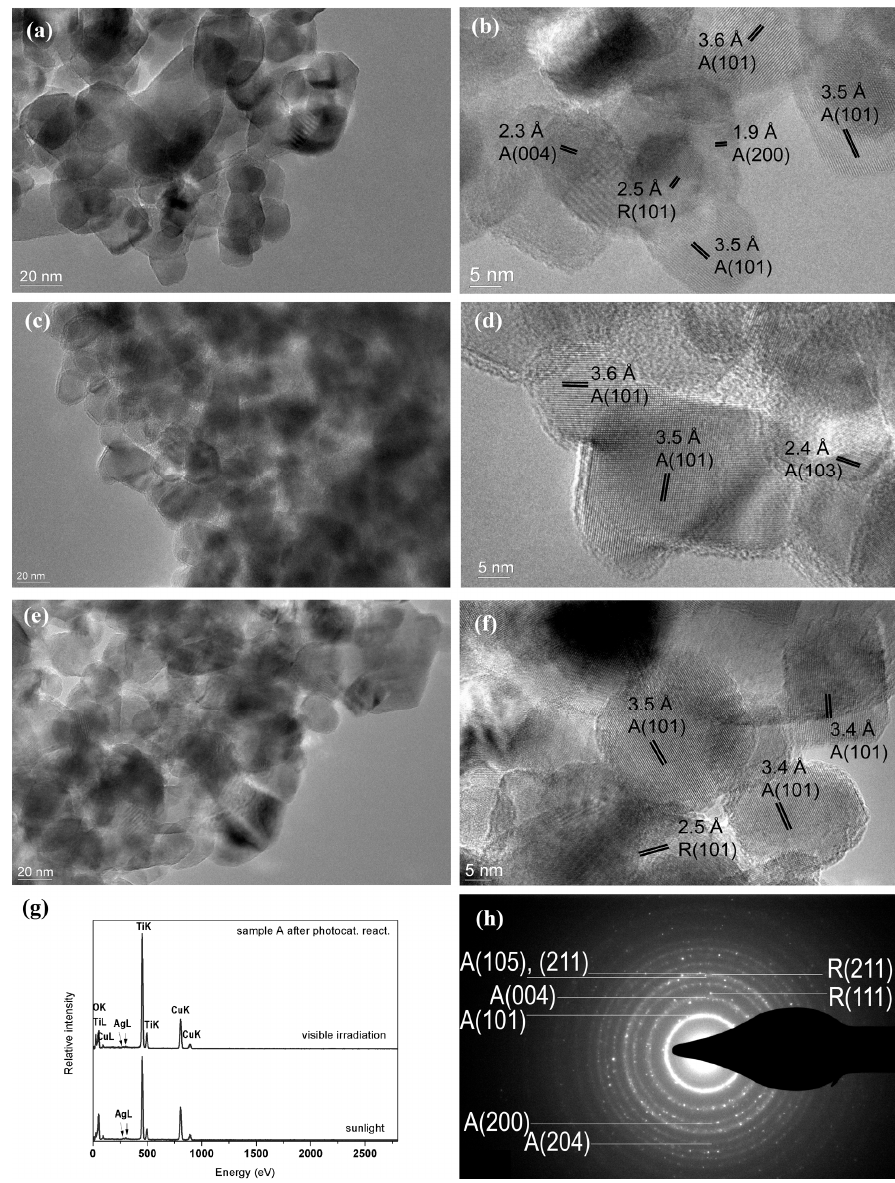
Figure 3. Sample S2: TEM ( a ) and high resolution transmission electron microscopy (HRTEM) ( b ) images before photo ‐ catalytic reaction, TEM ( c ) and HRTEM ( d ) images after photo ‐ catalytic reaction using only visible part of the spectra, TEM ( e ) and HRTEM ( f ) images after photo ‐ catalytic reaction using sun light, energy dispersive X ‐ ray spectroscopy (EDXS) of the sample after photo ‐ catalytic reaction using both visible irradiation and sun light ( g ) SAED of the sample after photo ‐ catalytic reaction using sun light ( h ).